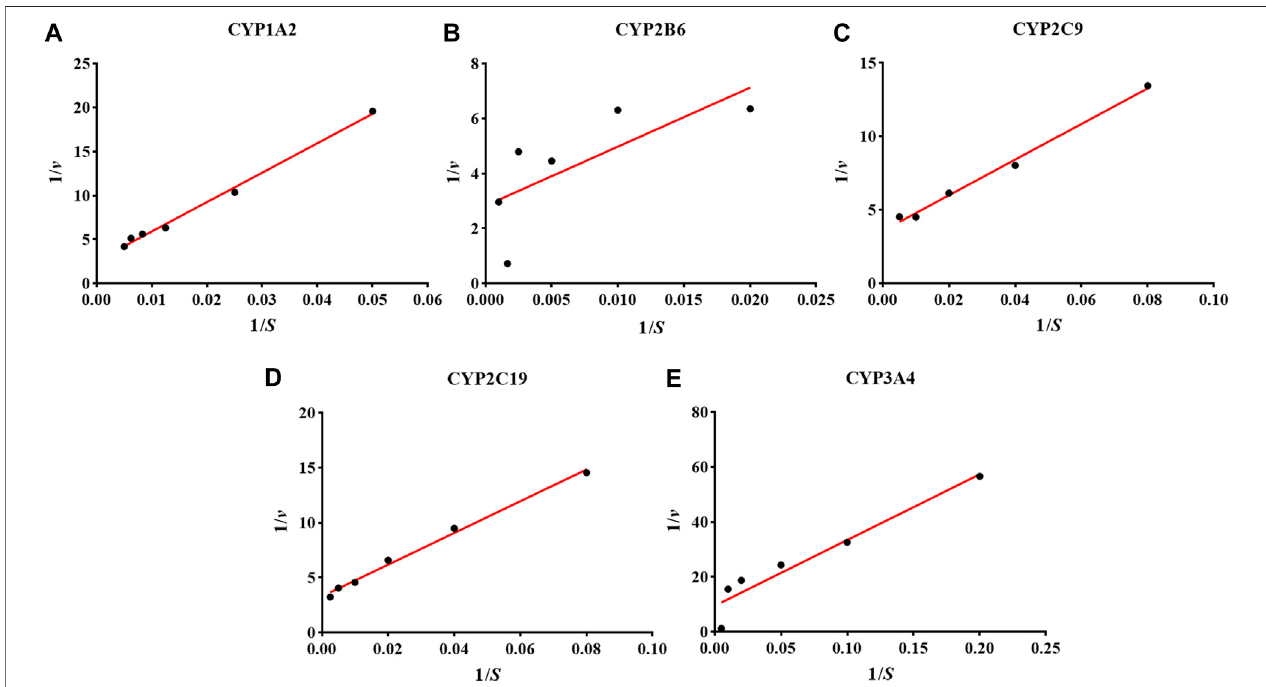
FIGURE 1 | The results of the Lineweaver-Burk plot of CYP1A2 (A) , CYP2B6 (B) , CYP2C9 (C) , CYP2C19 (D) , and CYP3A4 (E) in the hiHeps model.